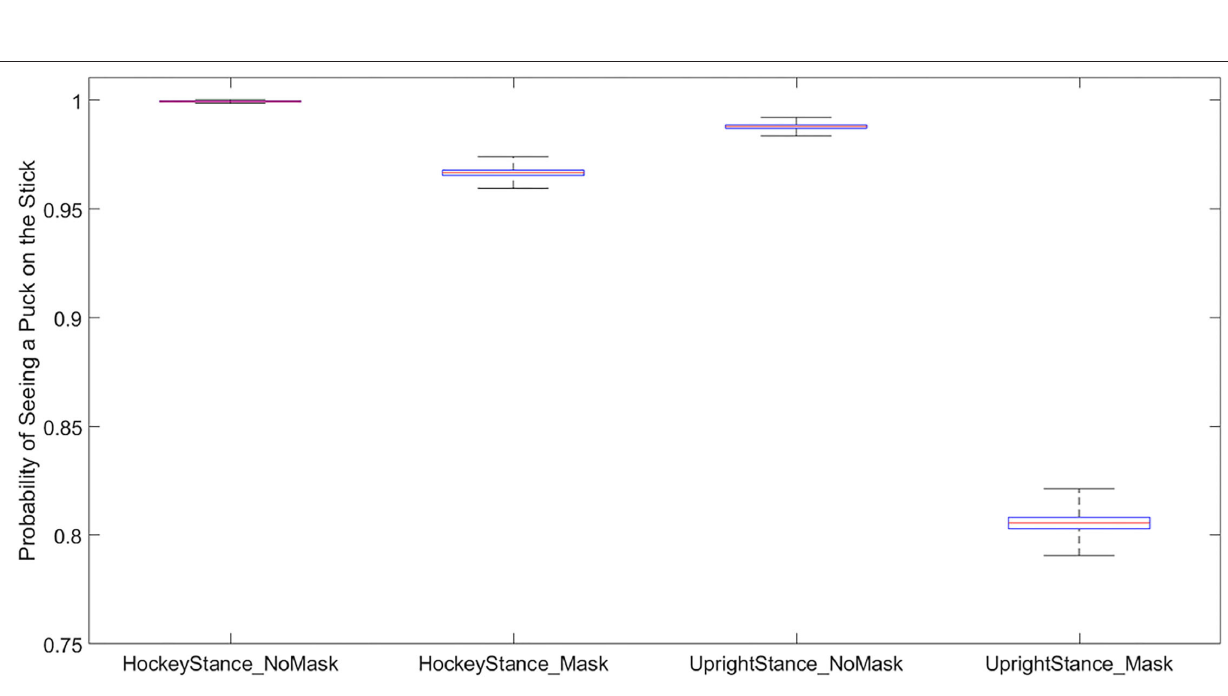
FIGURE 3 | A box plot depicting the cross model results. This plot shows the percent chance the player could see the center of the stick blade compared across various conditions. The y-axis is the probability that the puck will be seen (yes = 1), note the significant drop in puck on stick visibility ( ∼ 20%) when masked players are more